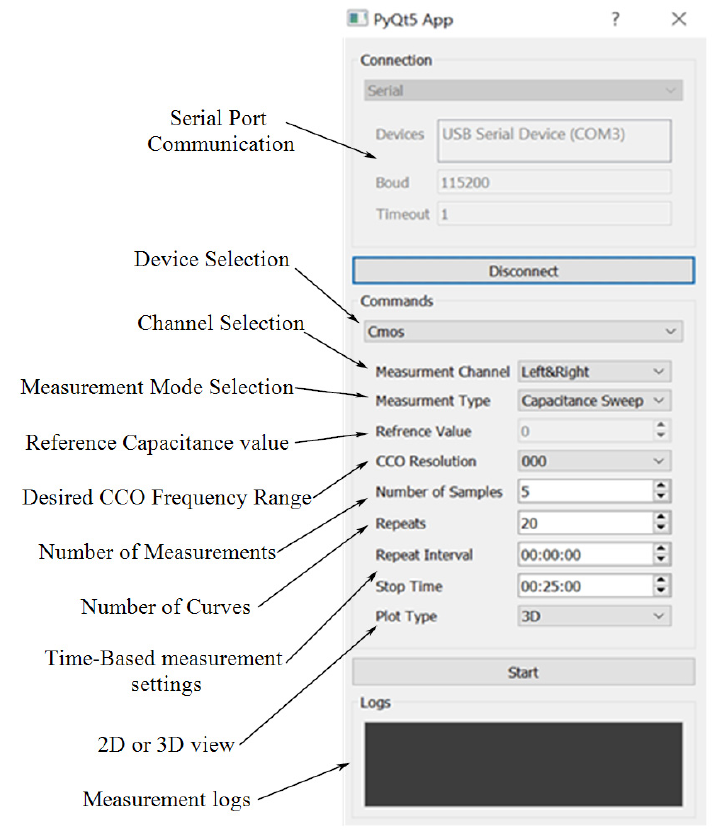
Figure 10. A snapshot of the GUI.